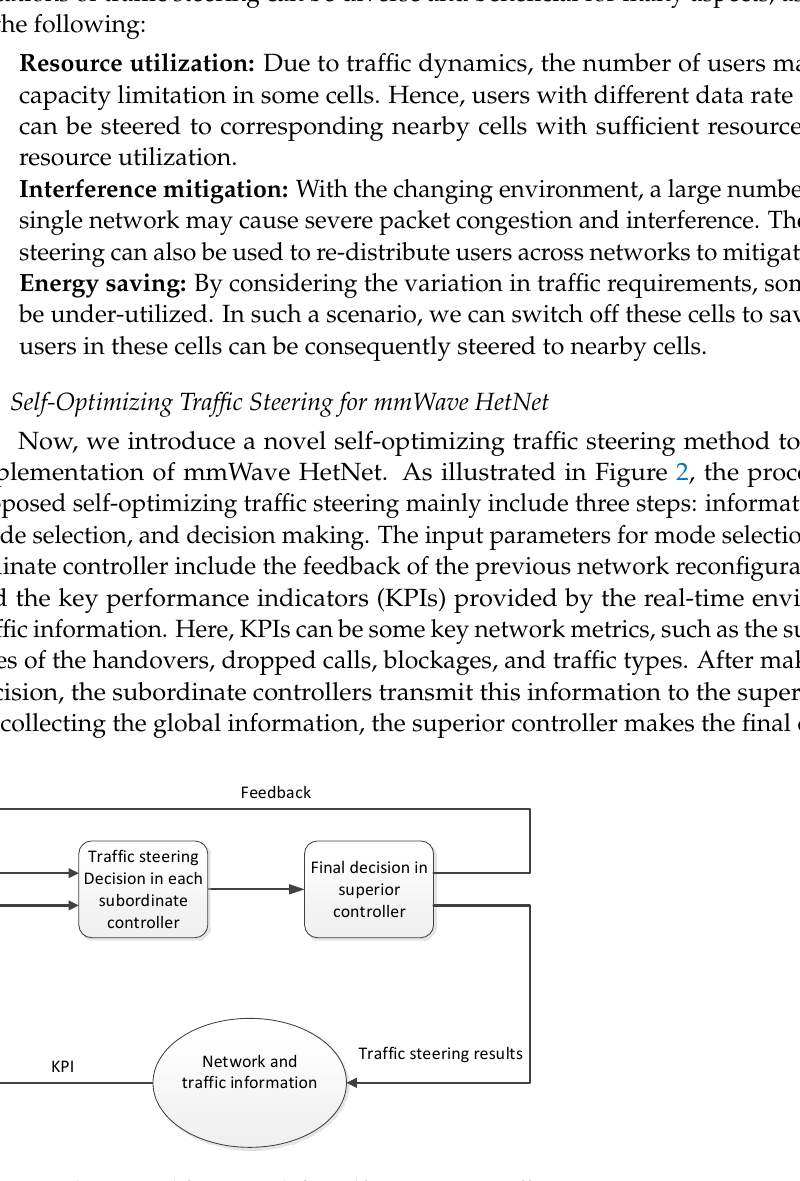
Figure 2. The general framework for self-optimizing traffic